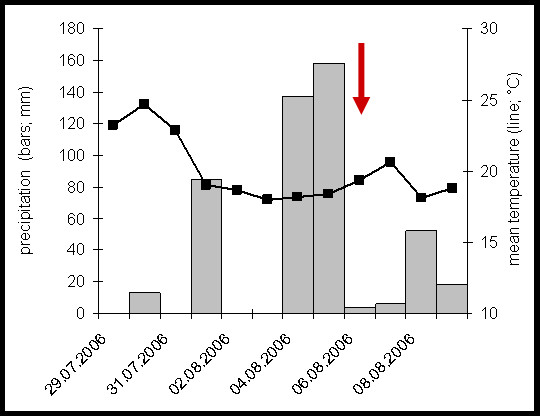
Rainfall and temperature records for Heidelberg around the time of the triathlon (6th August, 2006). The date of the triathlon is indicated by the red arrow.